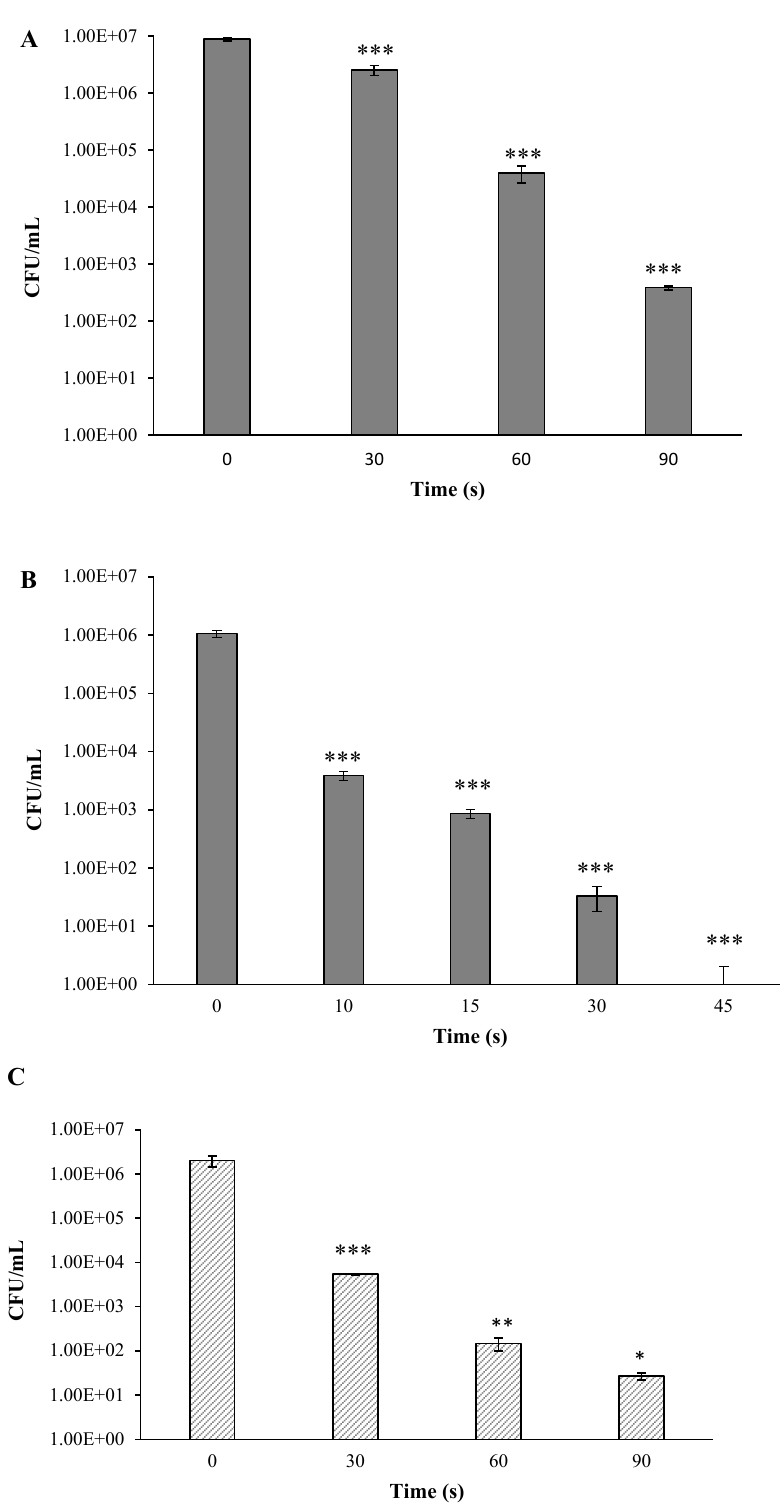
Figure 2. A. tumefaciens CFU/mL as a function of plasma corona-discharge exposure duration, in a dry environment with an initial bacterial concentration of 10 7 CFU/mL and 10 6 CFU/mL ( A , B ), respectively, and in liquid conditions with an initial bacterial condition of 10 6 CFU/mL ( C ). Results are mean STDEV of four independent experiments. * p < 0.005, ** p < 0.005, and *** p < 0.0005, compared to control, determined by t -test.